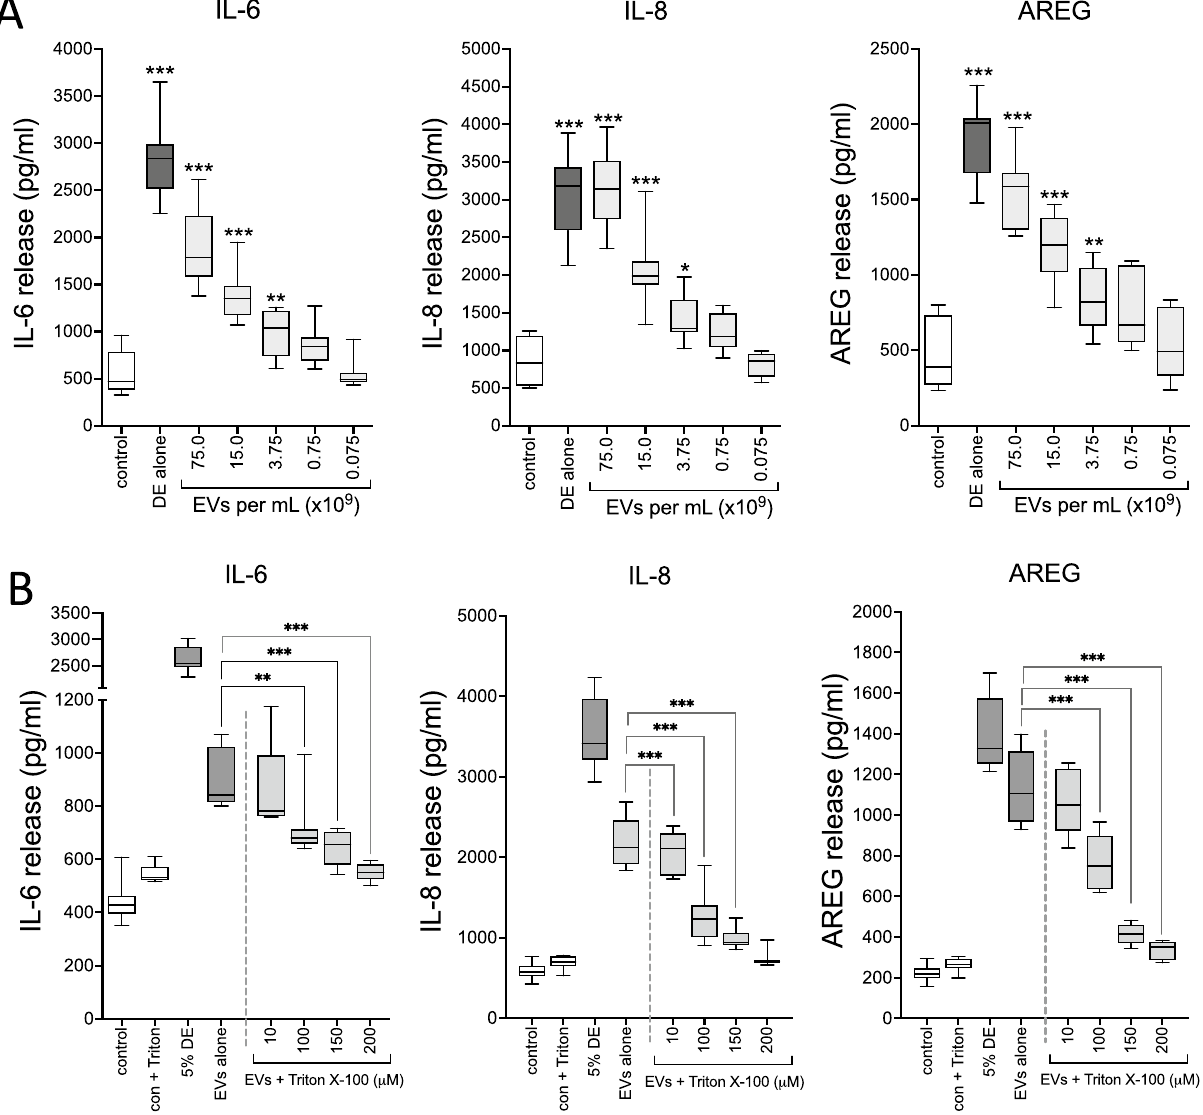
Figure 3. DE-derived EVs dose-dependently stimulated inflammatory mediator release from bronchial epithelial cells, and detergent lysis of EVs reduced their potency. BEAS-2B cells were treated with various concentrations of DE-derived EVs, or 5% complete DE, and incubated for 24 h. IL-6, IL-8, and AREG were measured in culture supernates ( A ). Soluble protein release from HBEC challenged with EVs recovered from DE treated with doses of Triton X-100 is shown in ( B ). The medians ± quartiles of 3 independent experiments are shown (n = 12 technical replicates per condition for ( A ) and 8 replicates for ( B ). *p < 0.05, **p < 0.01, ***p < 0.0001 vs control (or for indicated comparisons in ( B ) (ANOVA, Tukey’s post-hoc